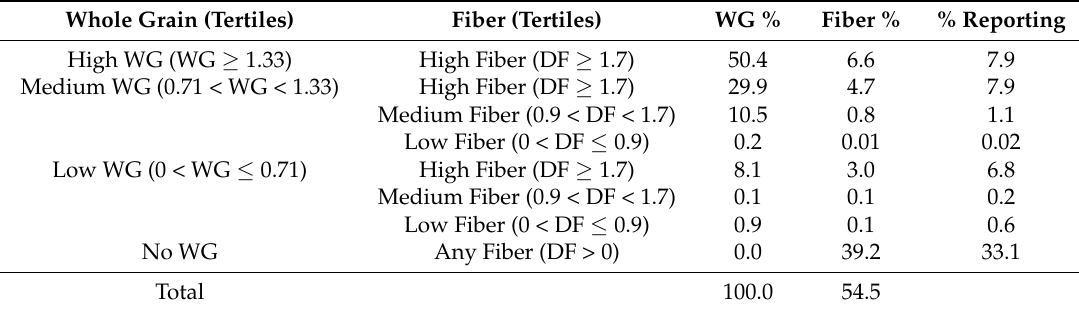
Table 2. Percent of whole grain and fiber consumed by tertiles of WG (oz. equivalents/100 g food)